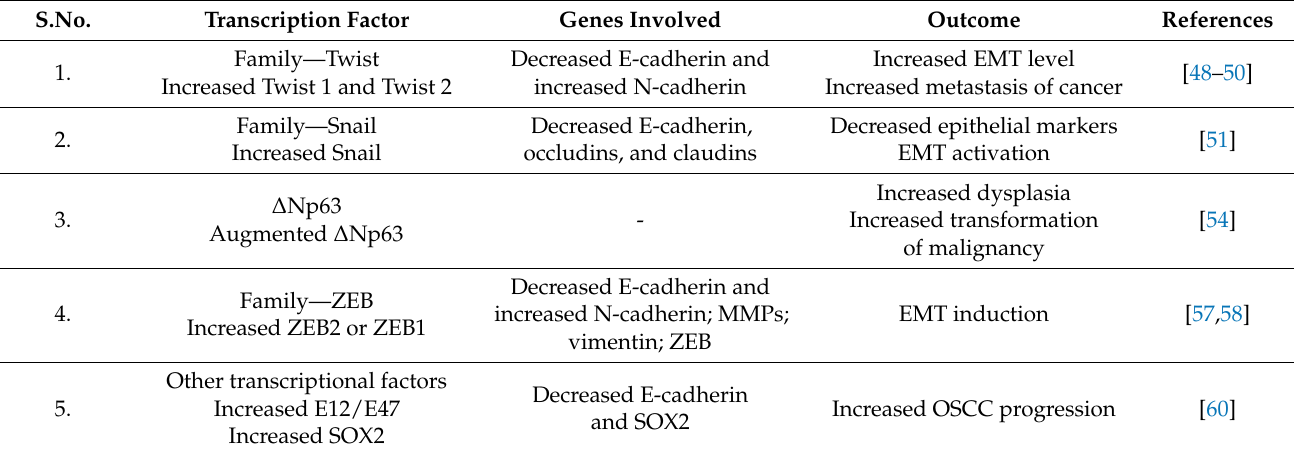
Table 2. Transcription factors induced by